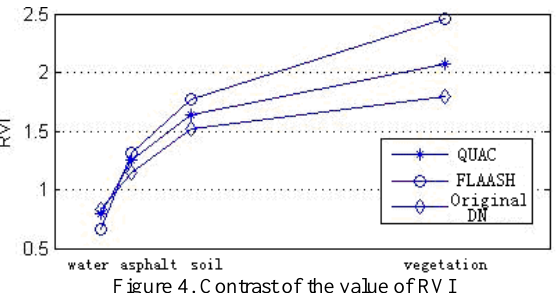
Figure 4. Contrast of the value of